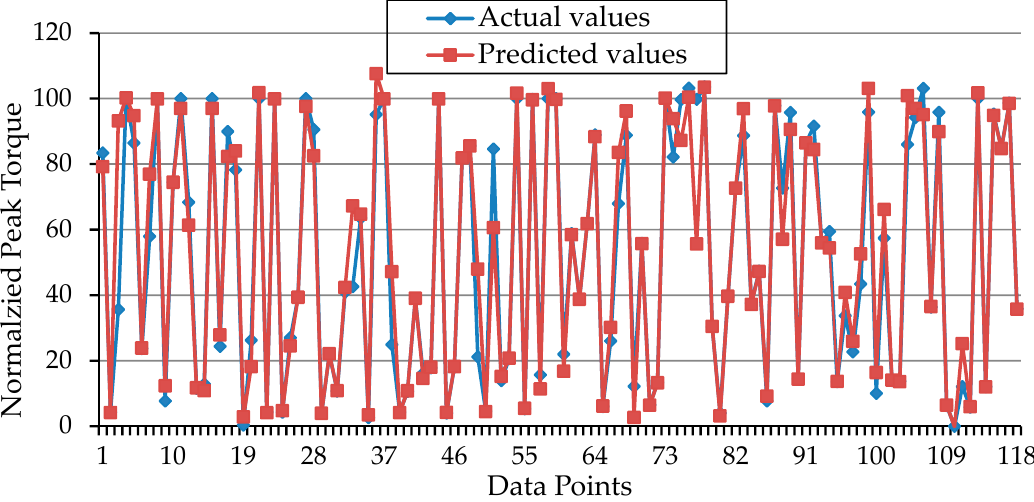
Figure 5. Cross plots of training sets—actual vs. predicted values: The plots show the performance of SVR with Gaussian kernel for torque prediction on the training set.